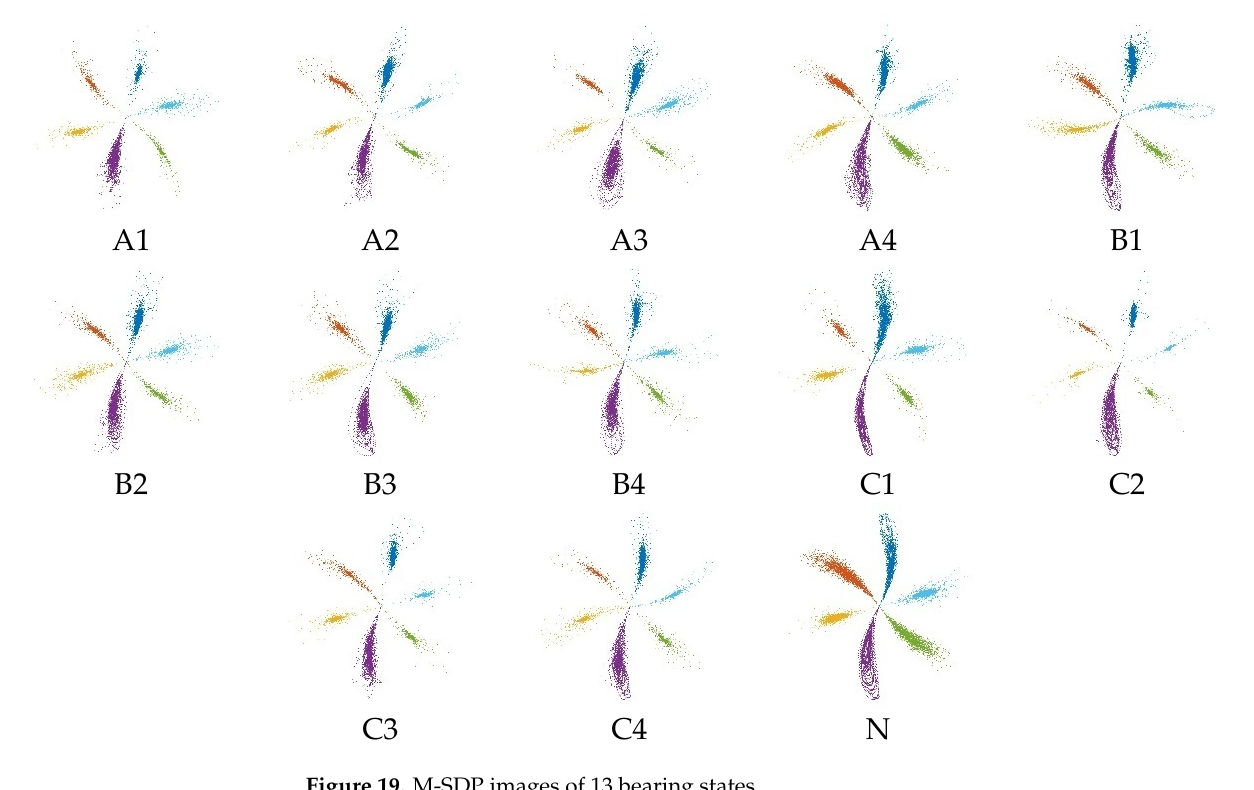
Figure 19. M-SDP images of 13 bearing states.